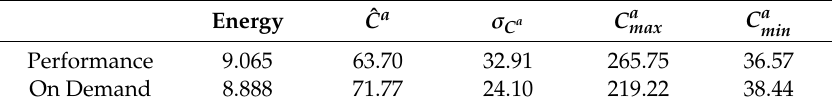
Table 12. Performance and OnDemand governors. Vid3.